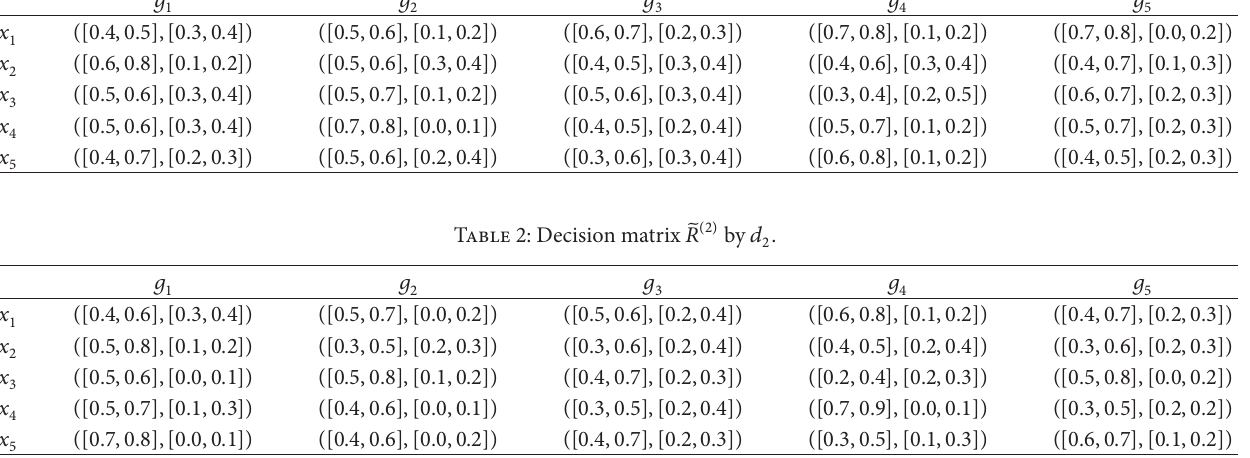
Table 1: Decision matrix